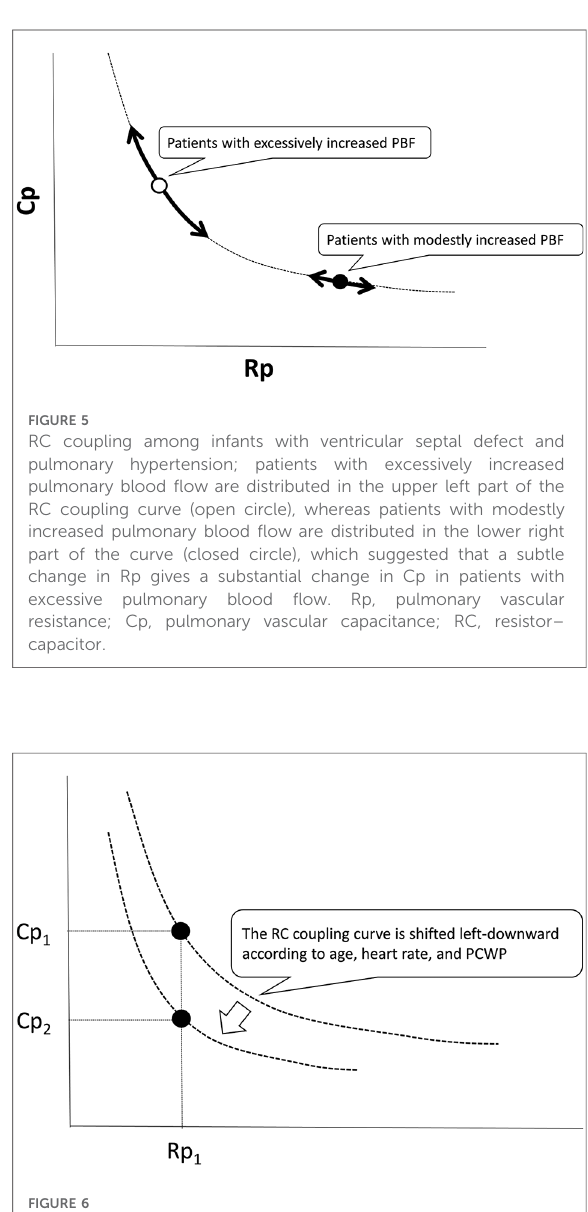
FIGURE 6 RC coupling curve can be shifted left-downward because the RC time can be altered according to age, heart rate, and pulmonary capillary wedge pressure. When the RC coupling curve is shifted, one value of Rp gives different values of Cp. Rp, pulmonary vascular resistance; Cp, pulmonary vascular capacitance; RC, resistor –